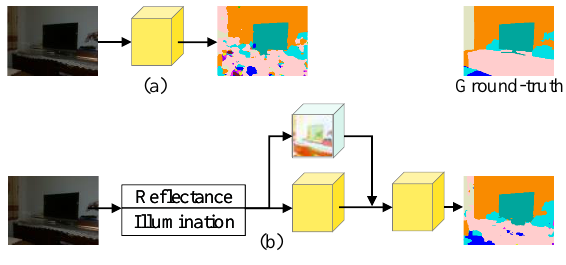
Figure 1. Compared with the direct segmentation of low-light images (a), our approach (b) seeks clues from illumination-invariant